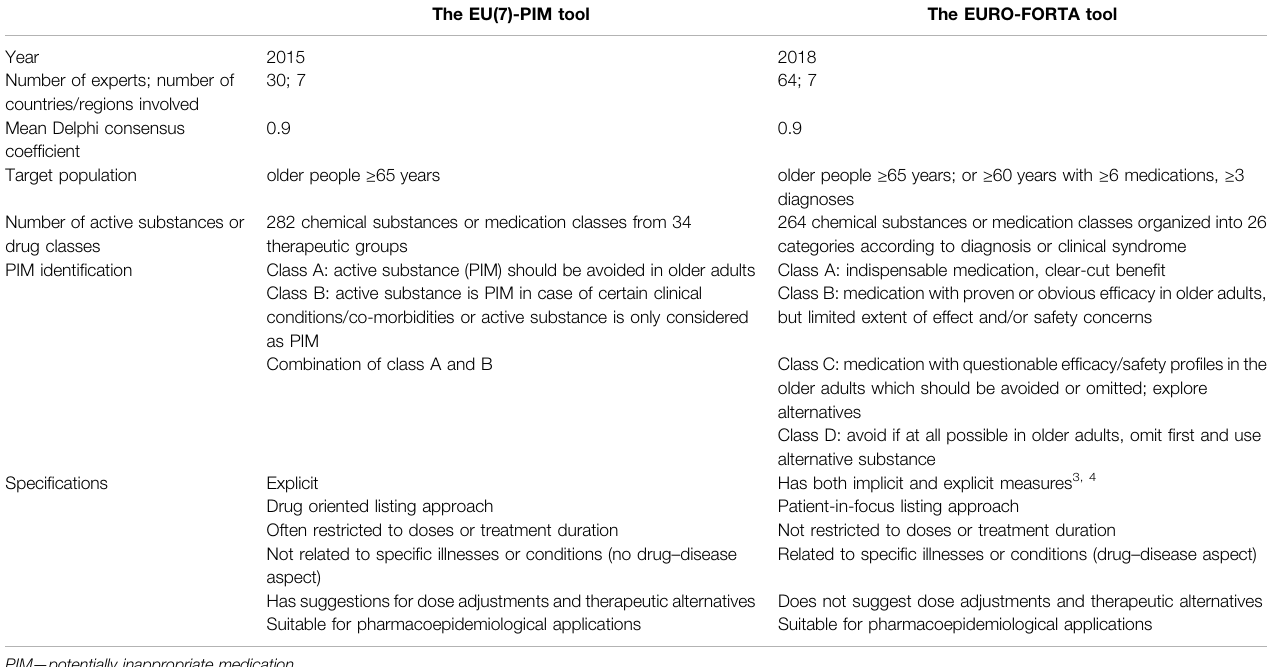
TABLE 1 | Short comparison of the explicit criteria-based EU(7)-PIM 1 and EURO-FORTA 2 tools. The EU(7)-PIM